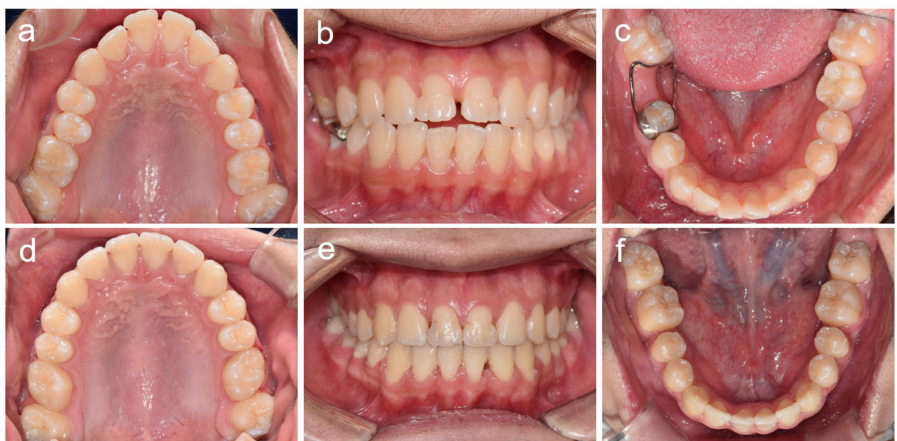
Figure 7. Clinical photos of patient 4. ( a – c ) Clinical photos at age 16 years 5 months. ( d – f ) Clinical photos at age 20 years 3 months.